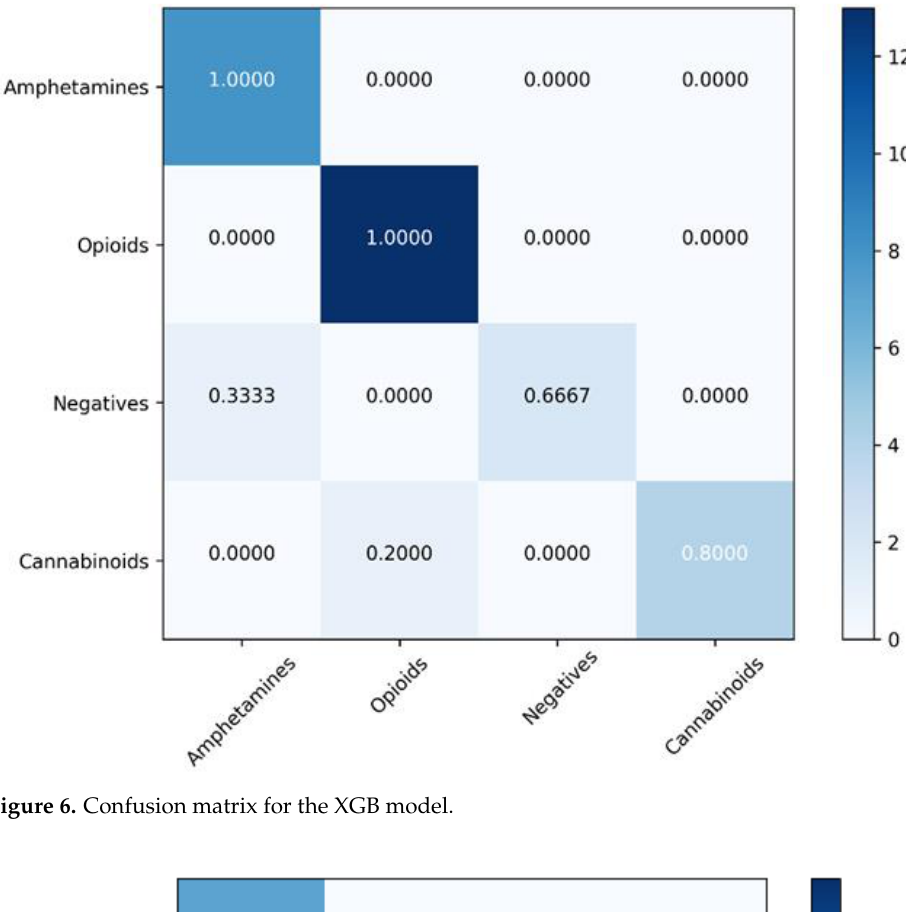
Figure 5. Confusion matrix for the SVM model.